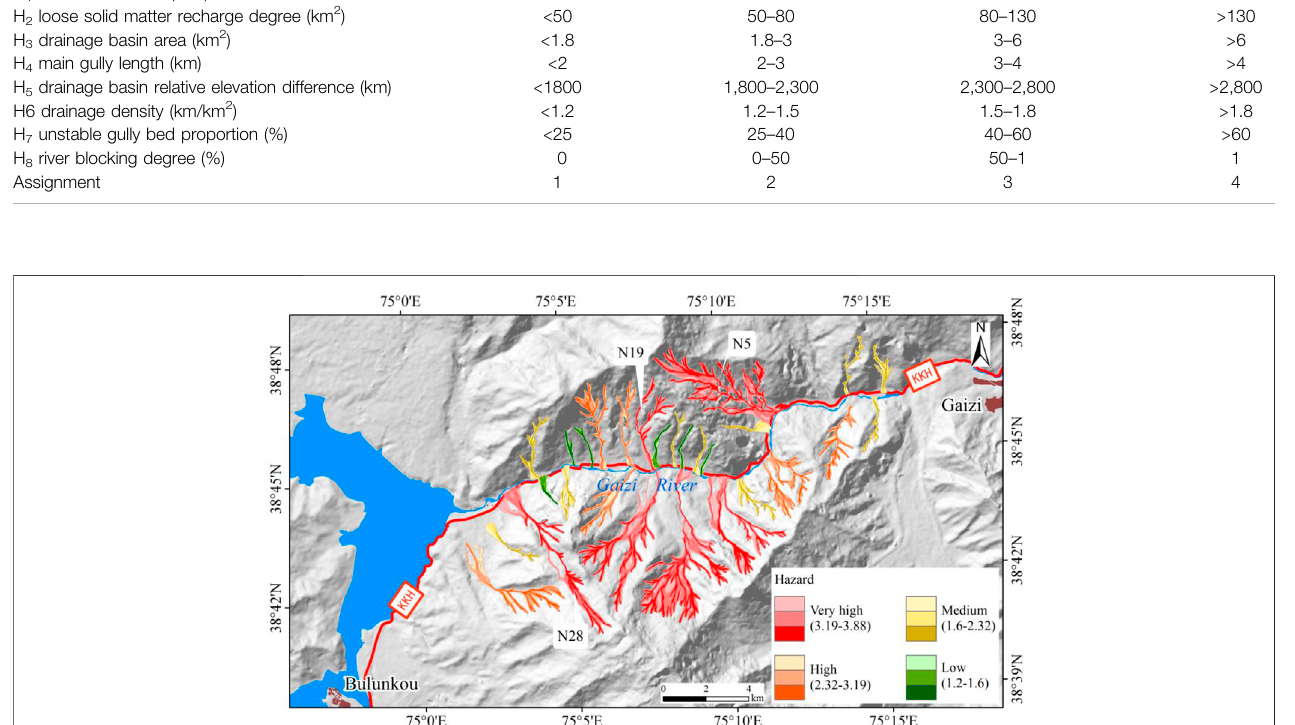
FIGURE8| Debris fl owhazardzonationmapoftheGaizi-BulunkouSectionoftheKarakoramhighway.Theyweredistinguishedbythesaturation,anddeepercolor means a higher spreading probability and destructive power.